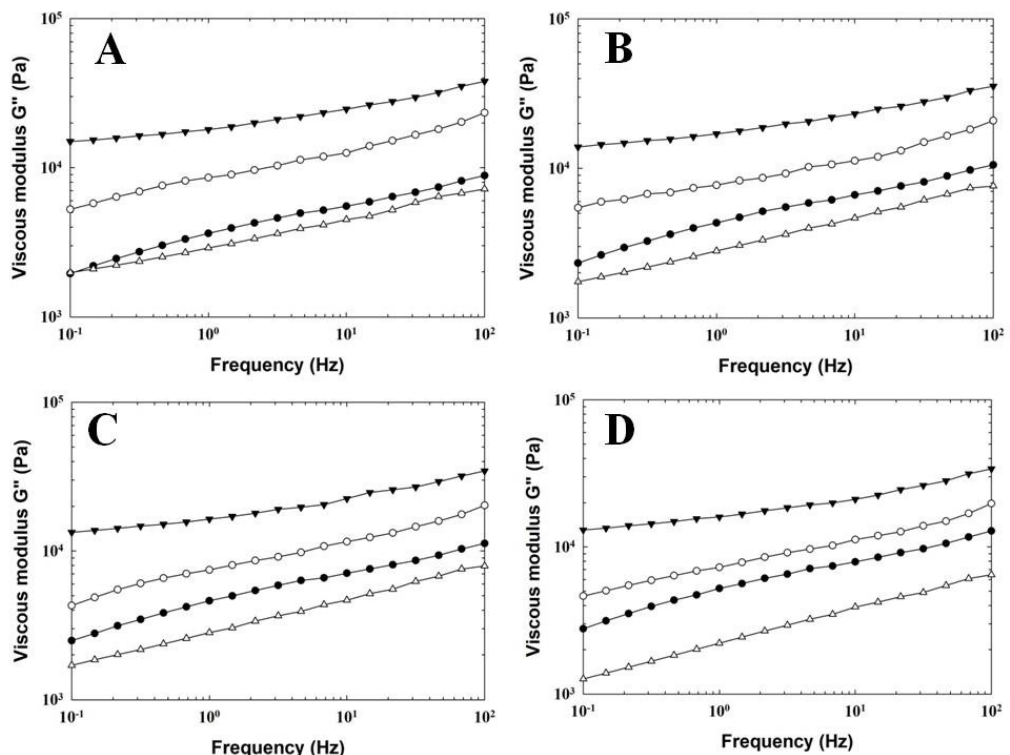
Figure 2. Development of elastic modulus G ′ values for processed cheese samples manufactured with different types of hydrocolloids (control sample—full circle; agar—open circle; κ‐ carragee ‐ nan—full triangle; gelatin—open triangle;) without emulsifying salts, a storage period of 60 days (at 6 ± 2 °C). Processed cheese samples were sampled after 2 (part A ), 9 (part B ), 30 (part C ), and 60 (part D ) days of storage.